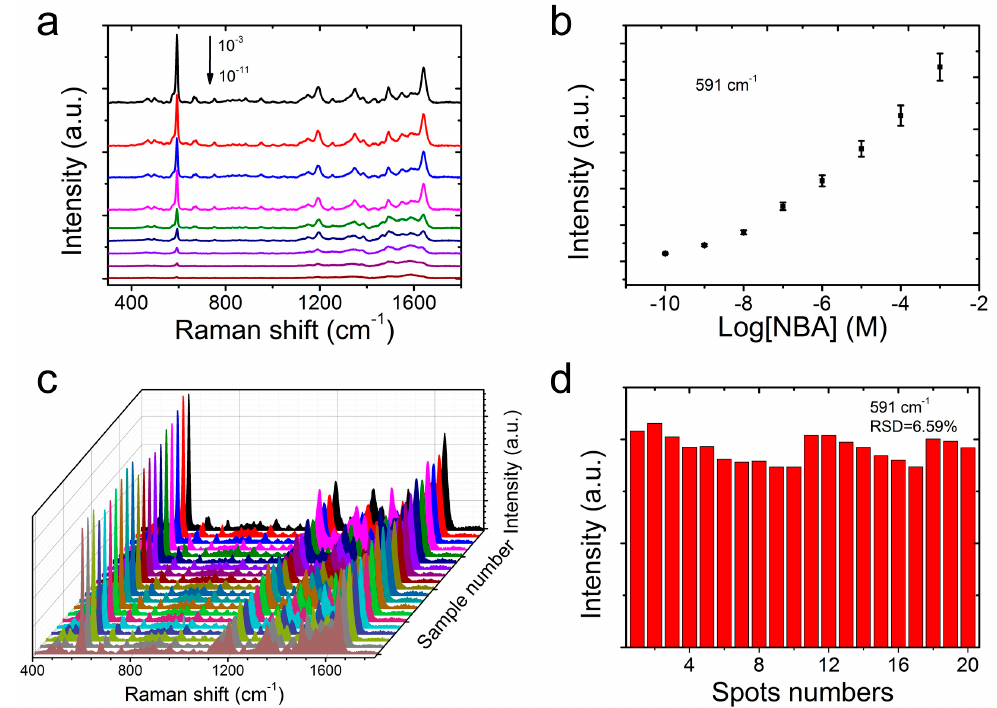
Figure 5. ( a ) The Raman spectra of the NBA probe molecules at different concentrations on the CS@PDA@AgNPs swabs. ( b ) The relationship between the signal intensity at 591 cm − 1 of the NBA molecules and the corresponding logarithmic concentration. ( c ) The SERS homogeneity of the CS@PDA@AgNPs swabs from 20 randomly selected points. ( d ) The Raman intensity distribution of the NBA molecules at 591 cm − 1 collected from 20 randomly selected points.